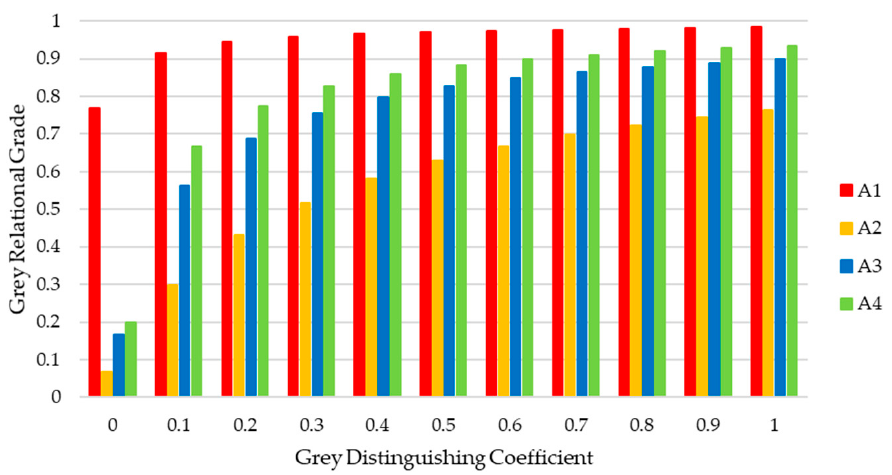
Figure 5. Grey distinguishing coefficient sensitivity analysis of the GRA.